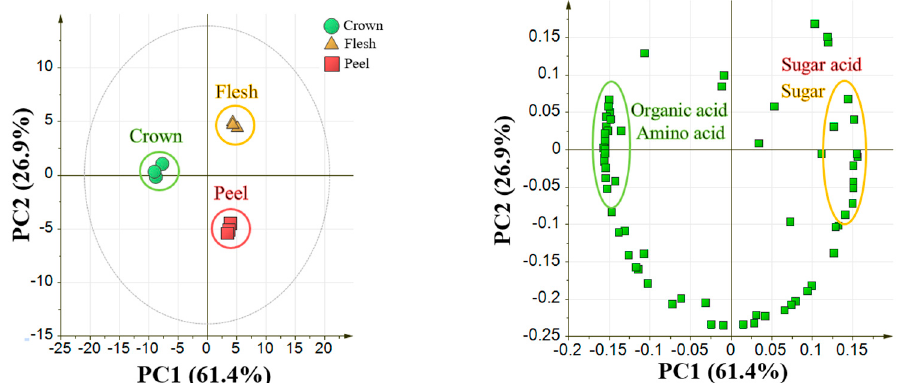
Figure 3. PCA result from different parts of pineapple. 64 tentatively identified metabolites from GC-MS analysis were auto-scaled prior to PCA. Left: Score plot between crown, flesh, and peel part. Legends represent the sample and colored as follows: crown: green circle, flesh: yellow triangle, peel: red square. Right: Loading plot shown that crown part accumulates organic and amino acid, while flesh and peel accumulate sugar and sugar acid.